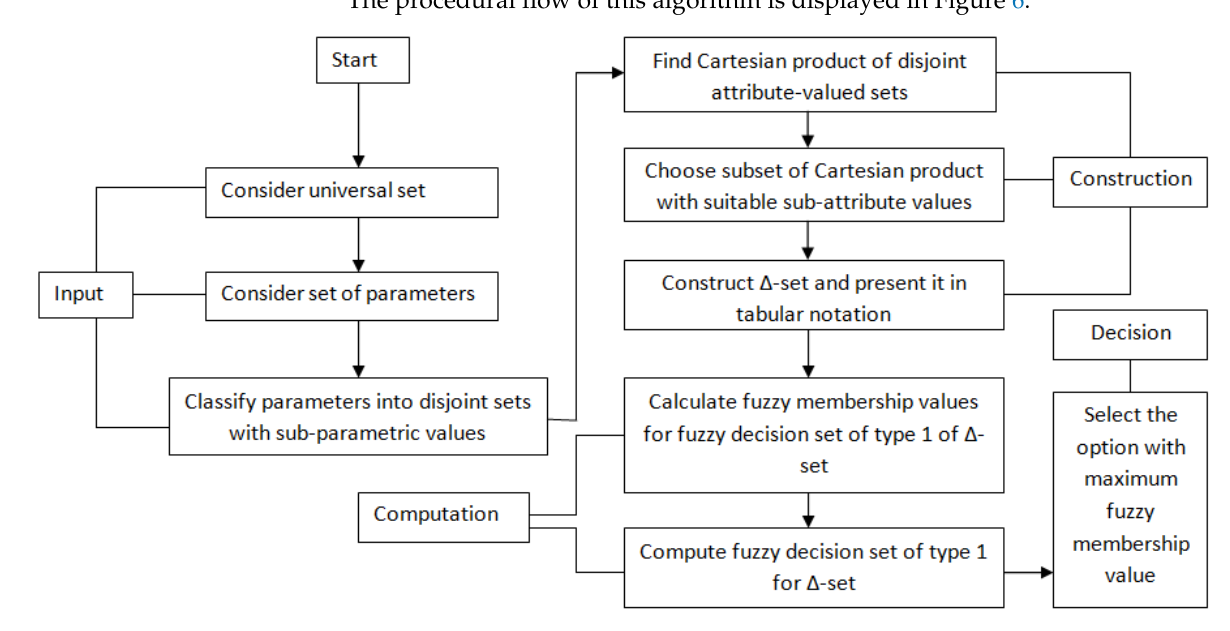
Figure 6. Algorithm Based on Decision Set of